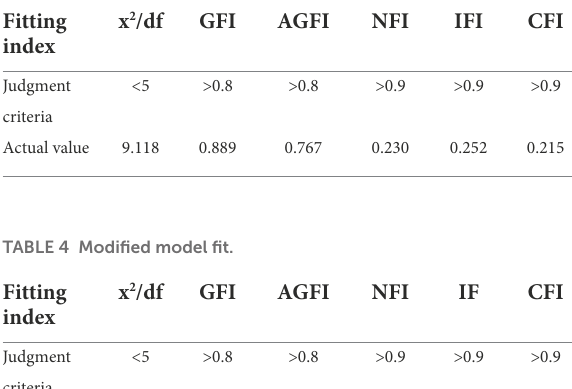
TABLE 3 Evaluation of model fit.